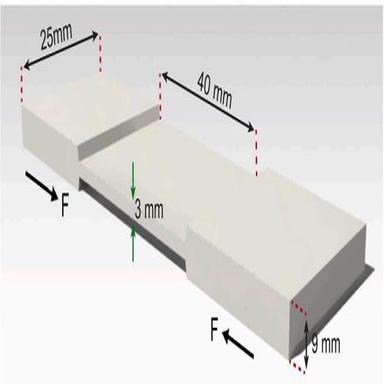
Dimension of the specimen in the compression test.